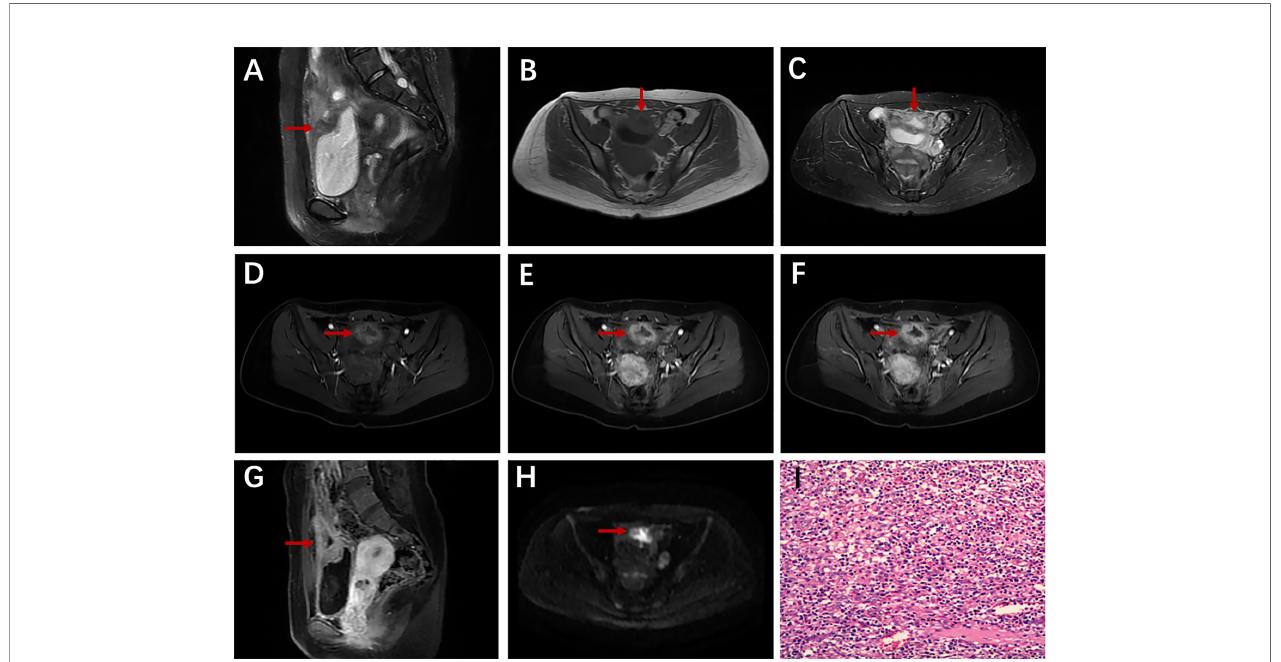
FIGURE 5 | A 32-year-old woman with urachal cyst and infection presented with pollakiuria. Sagittal T2WI (A) showed a heterogeneous mass at the junction of the urachus and bladder; the cyst wall showed iso-intensity on T1WI (B) and slightly hyperintensity on T2WI (C) ; axial dynamic contrast-enhanced LAVA-Flex images showed apparent enhancement of the cyst wall (D – G) ; mildly restricted diffusion in the cyst wall on DWI (H) ; Pathology showed a large number of acute and chronic in fl ammatory cell in fi ltration (I) .